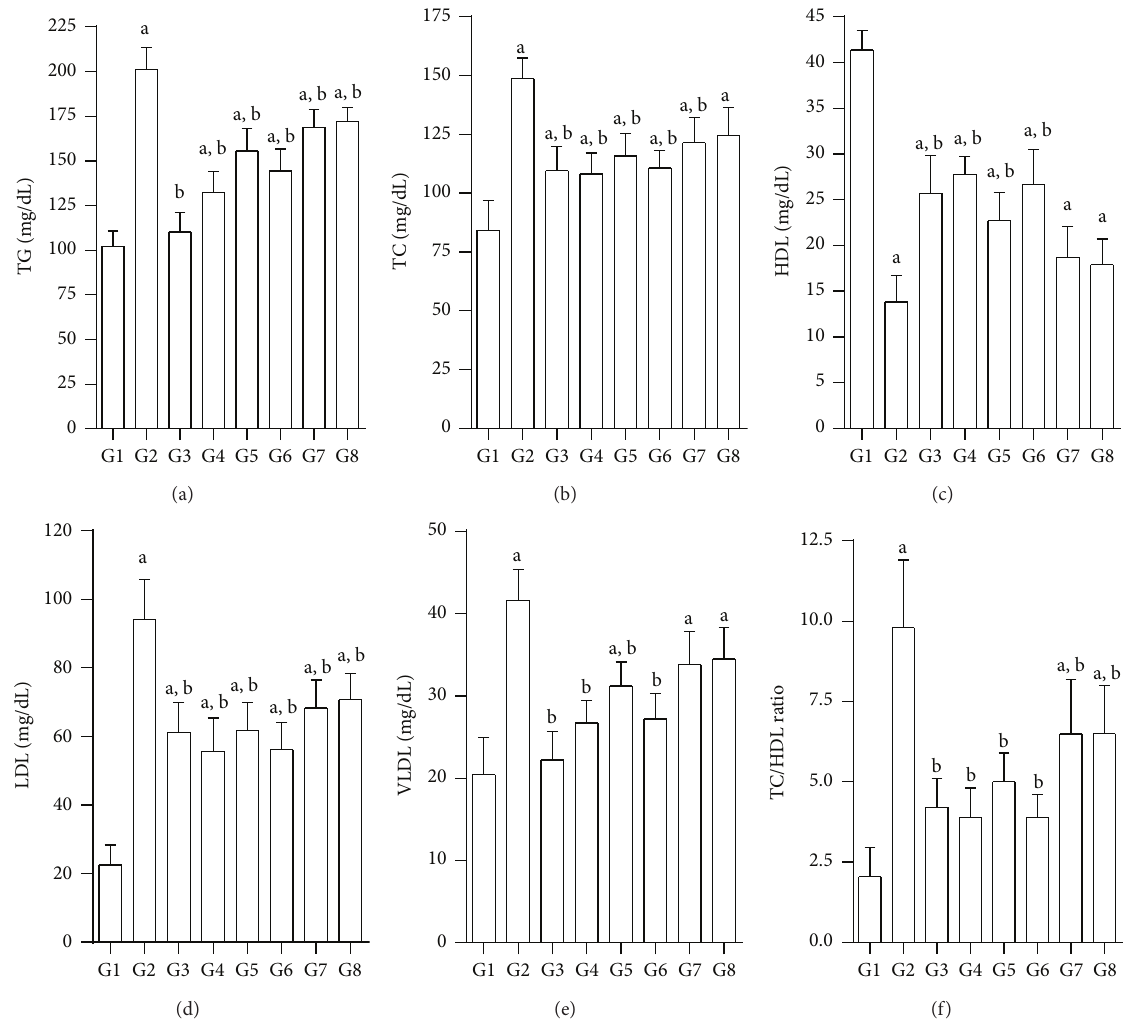
Figure 3: Effect of test compounds on serum lipids in nicotinamide-STZ rats; (a) TG, (b) TC, (c) HDL, (d) LDL, (e) VLDL (f) TC/DHL-ratio; G1: normal control; G2: diabetic control (nicotinamide + STZ); G3: diabetic + glibenclamide (2.5 mg/kg); G4: diabetic + quercetin (10mg/kg); G5: diabetic + JY-1; G6: diabetic + JY-2; G7: Diabetic + JY-3; G8: diabetic + JY-4; (test compounds at optimised dose of 80 mg/kg); all values mean ± SEM ( 𝑛 = 6 ); a 𝑃 < 0.05 compared to normal control (G1), b 𝑃 < 0.05 compared to diabetic control (G2) (one-way ANOVA followed by Tukey’s post-hoc